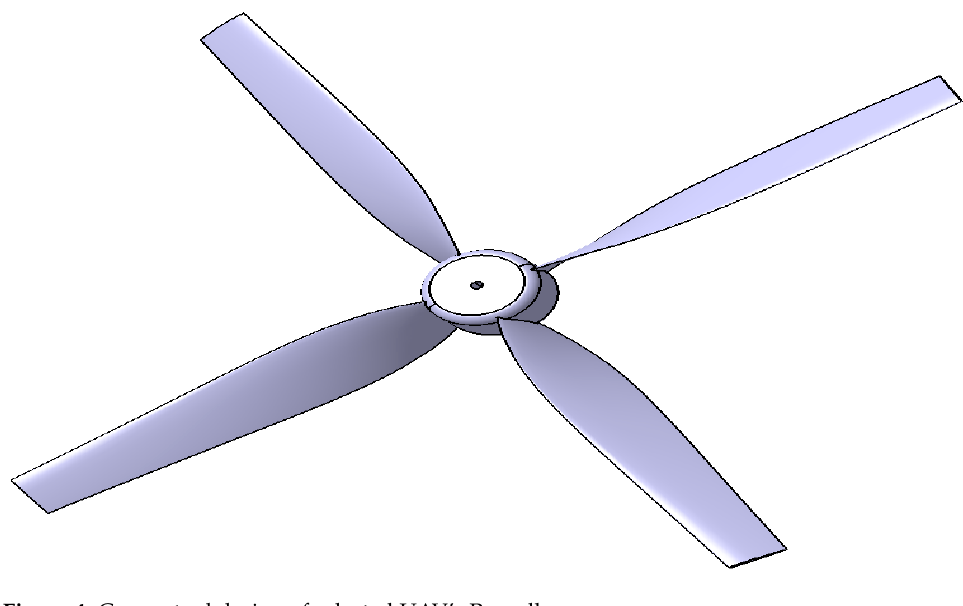
Figure 4. Conceptual design of selected UAV’s Propeller. The estimated values for wing dimensions are tabulated in Table 10. Table 10. Final estimated data of UAV.